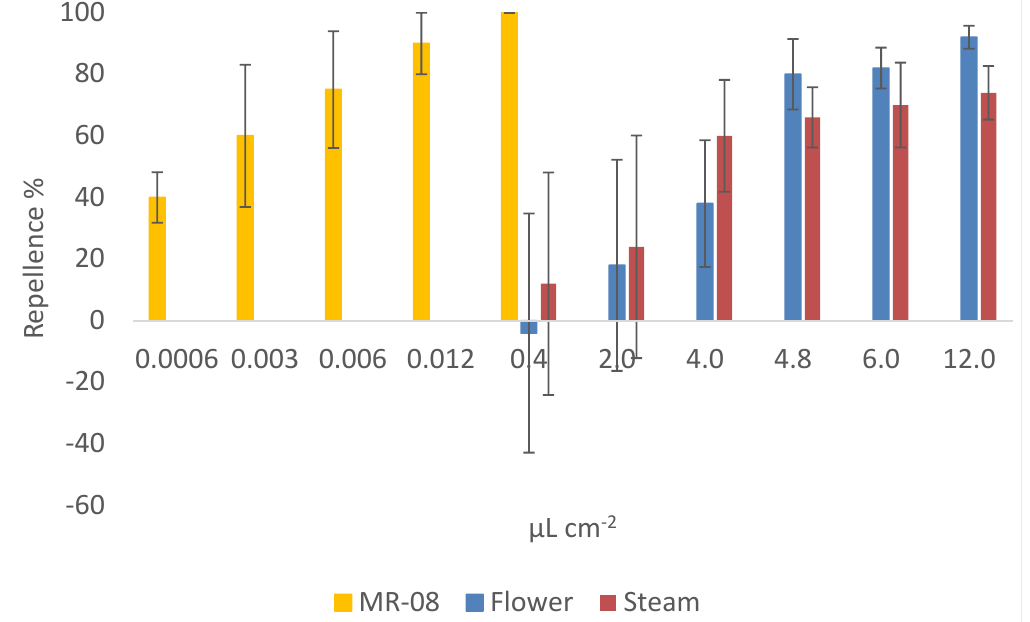
Figure 3. Mean repellence (%) of Lavandin flowers and stems aromatic waters and of the synthetic repellent MR-08 against Tribolium confusum adults. Bars represent standard error. The repellent e ff ect of the two Lavandin extracts was, however, lower than the one of the synthetic repellent MR-08 (ANCOVA F 2, 72 = 4.010; p = 0.022; η p2 = 0.10). In particular, the post-hoc tests of